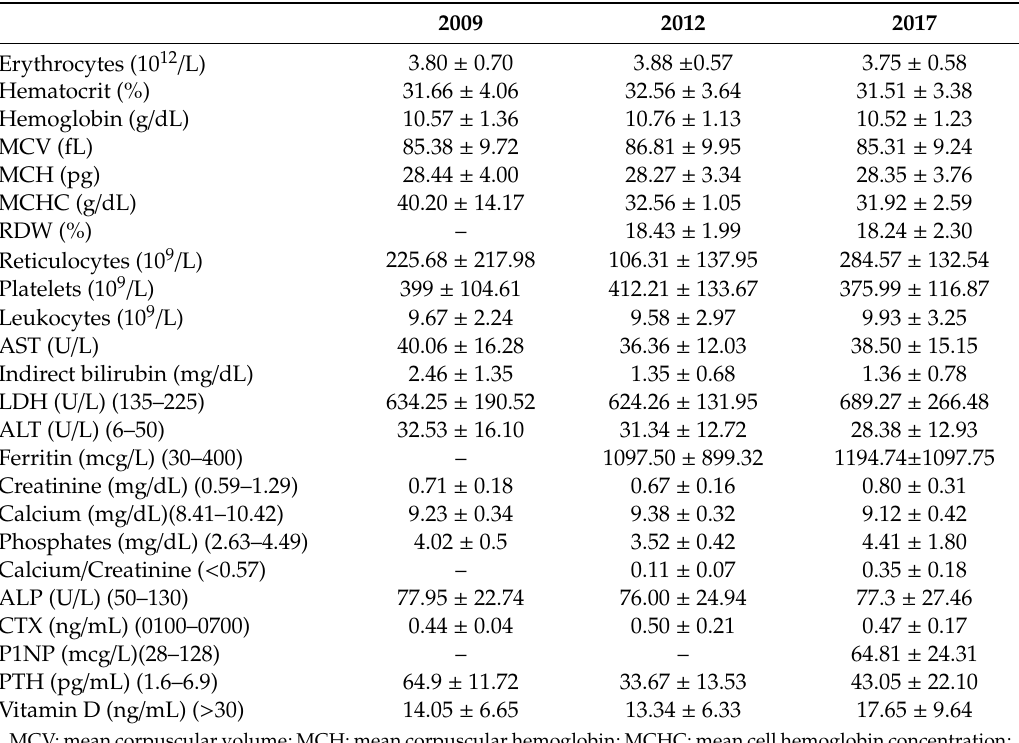
Table 2. Hematologic and biochemical data of patients with SCD